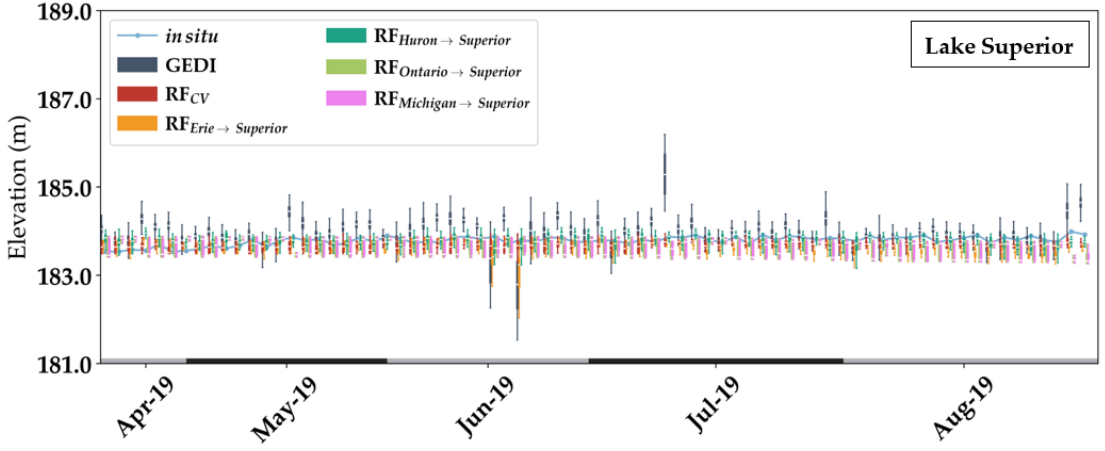
Figure A10. Cont